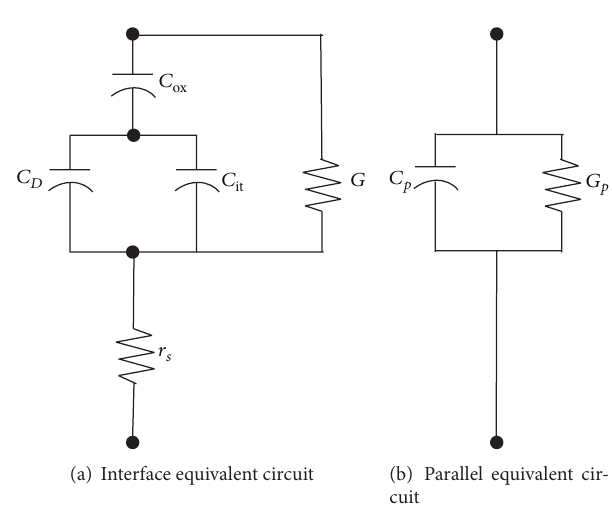
Figure 8: 𝐶 𝑝 and 𝐺 𝑝 equivalent circuits.